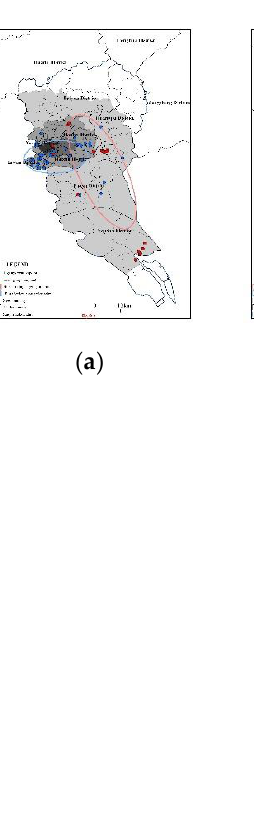
Table 7. Standard deviation ellipse parameters of total carbon emissions and per capita carbon emis- sions.